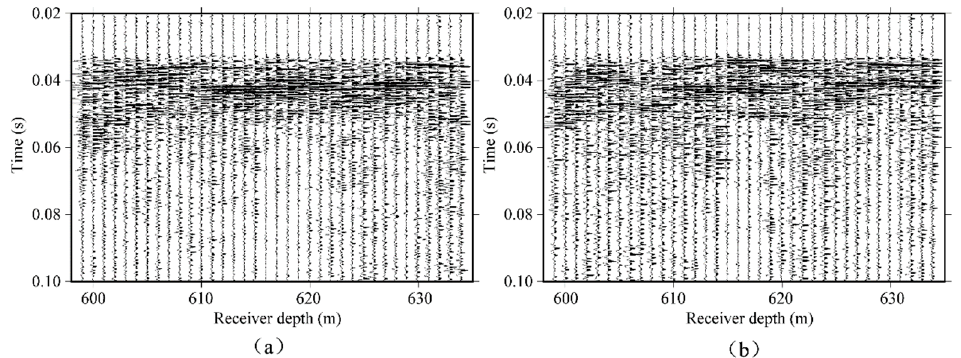
Figure 15. ( a ) An example shot gather from the baseline survey. ( b ) The corresponding shot gather from the second-repeat survey. Table 1. Processing steps used in the real time-lapse cross-well datasets.